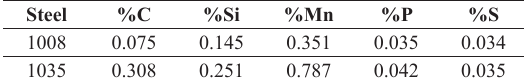
Table 1. Chemical composition of the 1008 and 1035 steels (mass %).